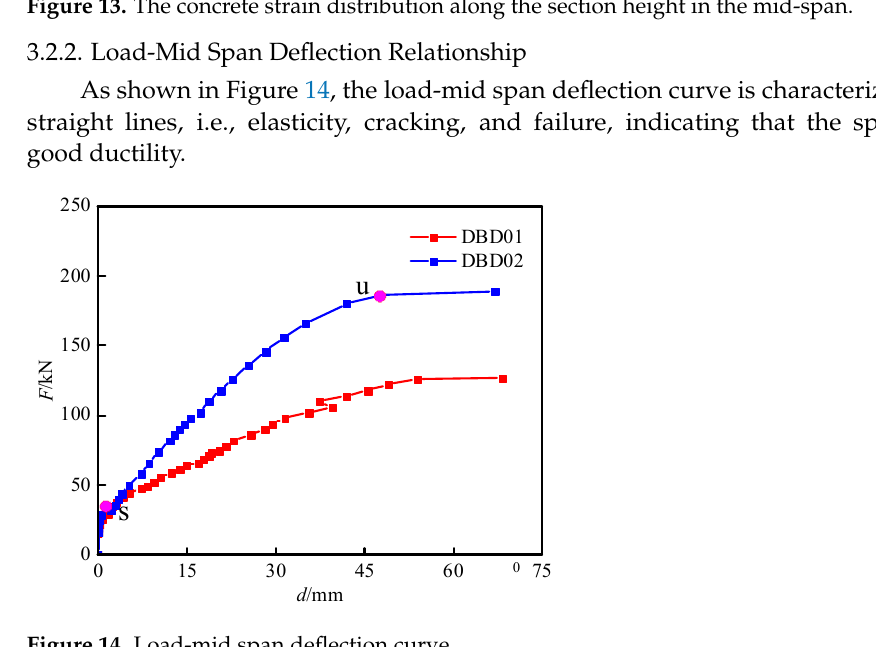
Figure 13. The concrete strain distribution along the section height in the mid-span.